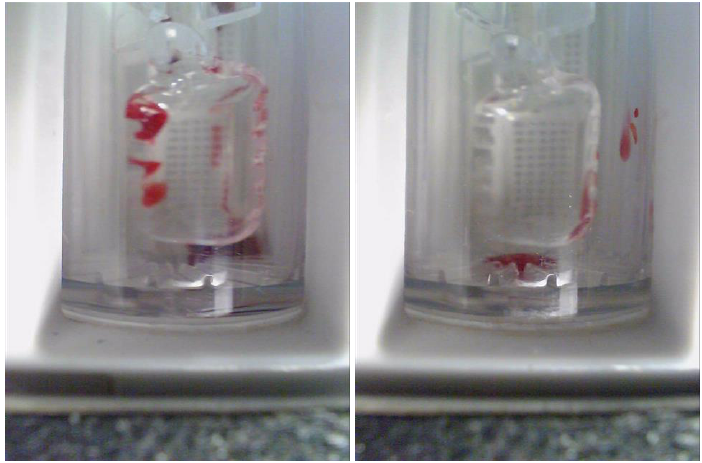
Figure 3. Small-ROI